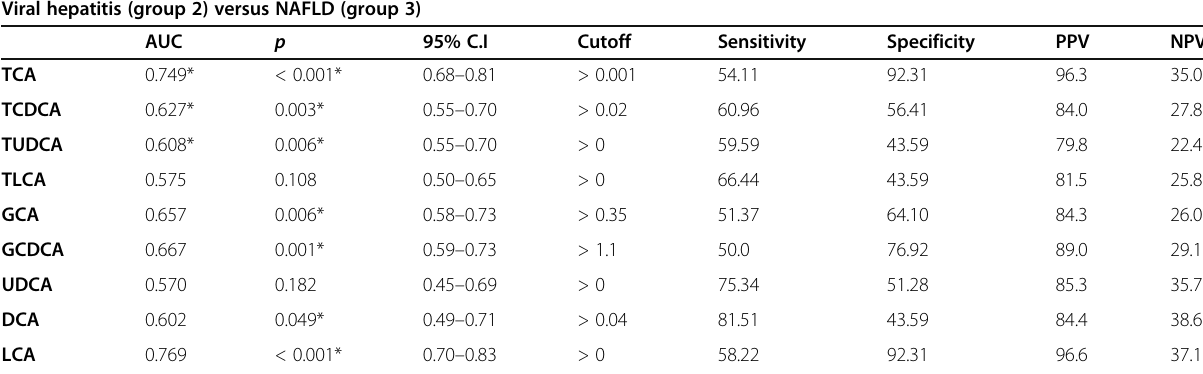
Table 3 Sensitivity, specificity, and diagnostic accuracy of serum bile acids levels to distinguish viral hepatitis from NAFLD Viral hepatitis (group 2) versus NAFLD (group